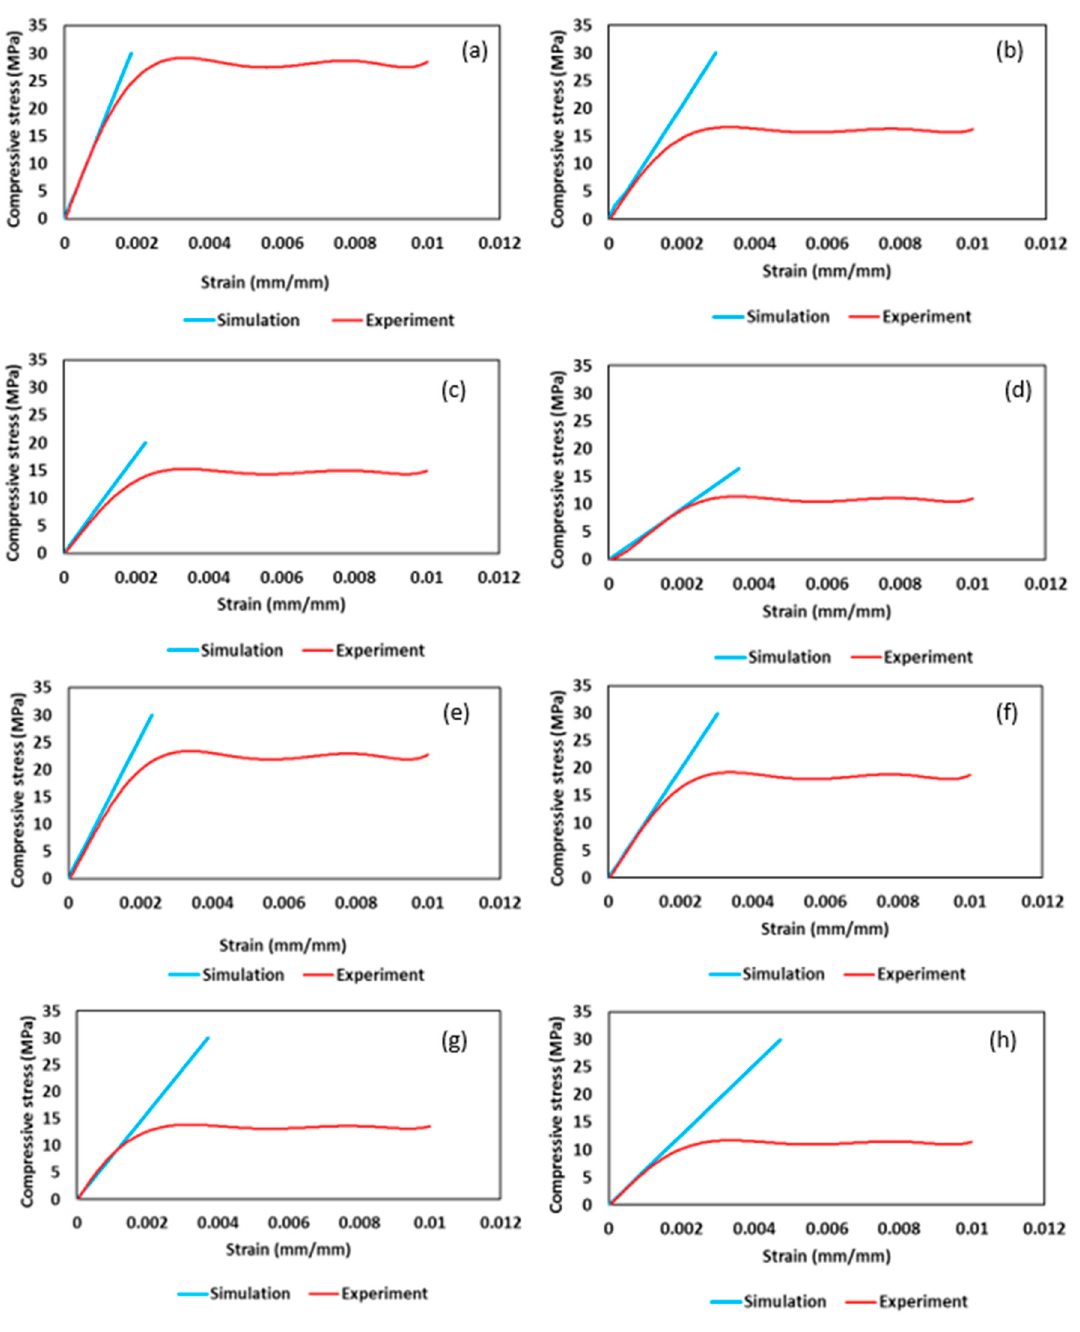
Figure 10. Numerical and experimental stress-strain curve for: ( a ) cube 0.3 mm; ( b ) cube 0.4 mm; ( c ) cube 0.5 mm; ( d ) cube 0.6 mm; ( e ) gyroid 0.3 mm; ( f ) gyroid 0.4 mm; ( g ) gyroid 0.5 mm; and ( h ) gyroid 0.6 mm.